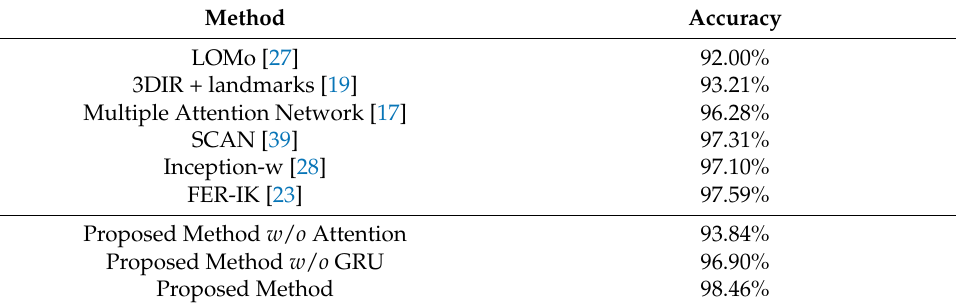
Table 3. Comparison of methods on CK+ dataset.